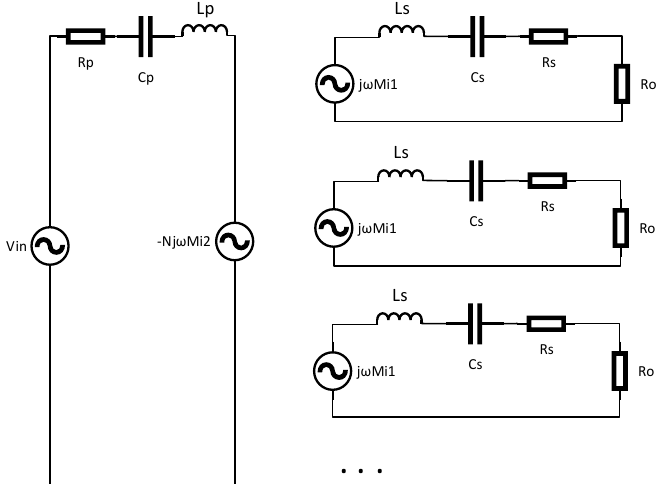
Figure 2. Equivalent circuit of wireless power transfer system.